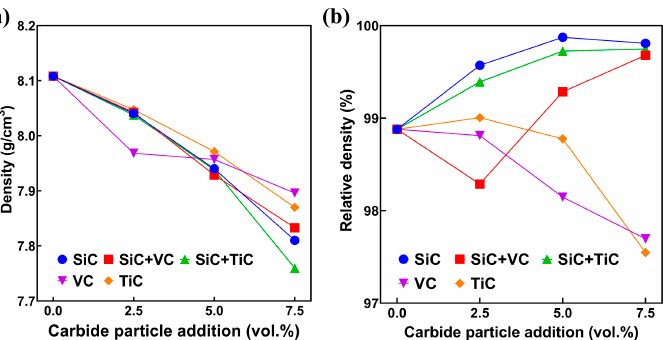
Figure 3. ( a ) The measured density and ( b ) calculated relative density of the S390 MMCs with an increasing volume fraction of carbides.